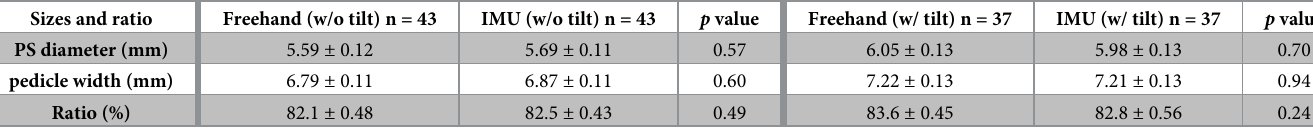
Table 3. Average diameters of the PS, narrowest width of the pedicle, and PS size-to-narrowest-pedicle width ratio.